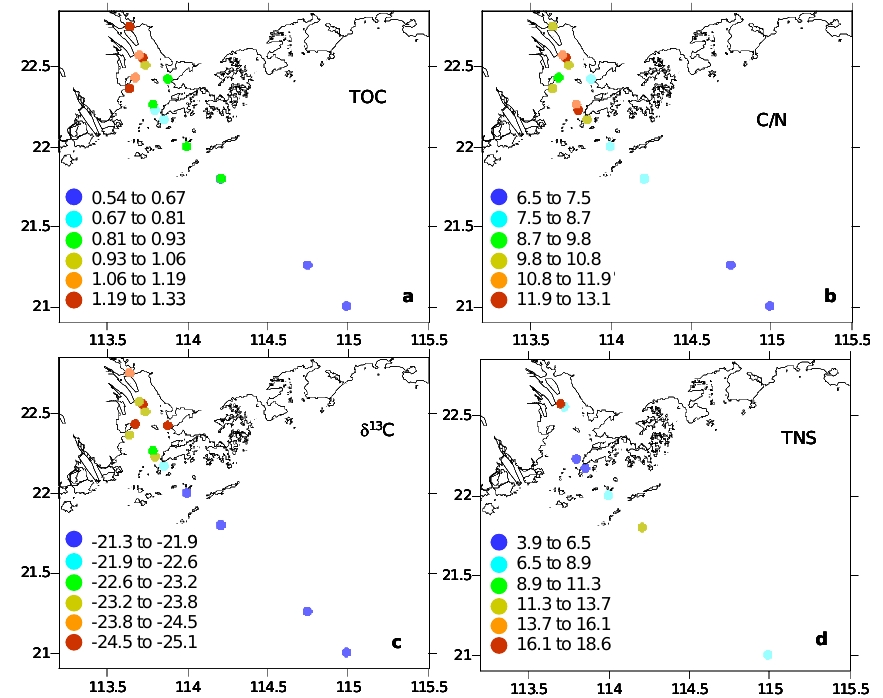
Fig. 4. Spatial distribution of TOC (%) (a) , C/N ratios (b) , δ 13 C (‰) (c) and TNS (mg neutral sugar (100mg OC) − 1 ) (d) in the surface sediment in Lingdingyang Bay and on the shelf of the South China